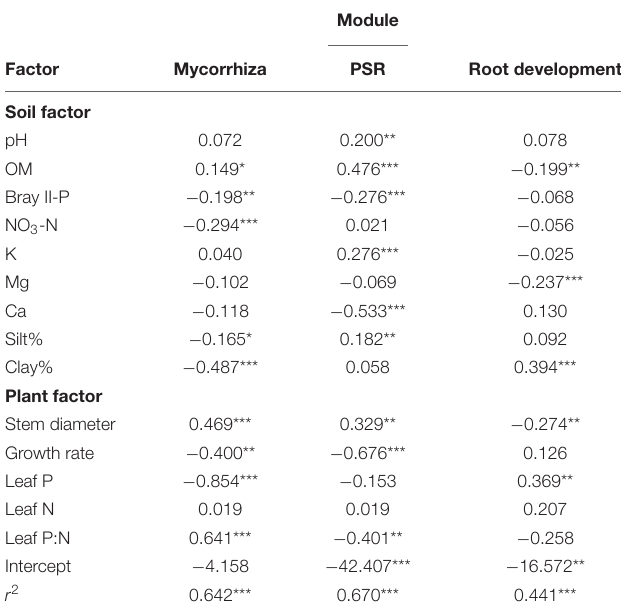
TABLE 3 | Coefficients of the soil and plant factors with the eigengenes of mycorrhizal, phosphate starvation response (PSR), and root development modules in multiple regression